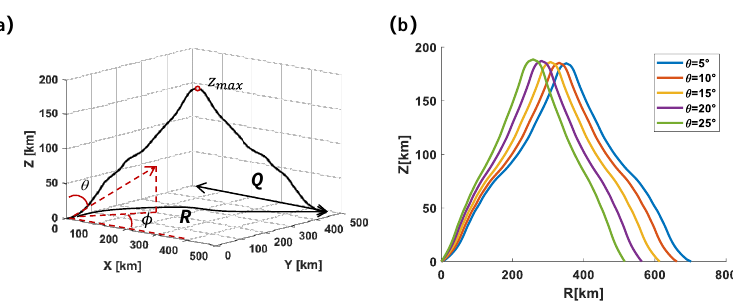
Figure 2. ( a ) Propagation trajectory of the tau-p model in a phase loop. R represents the infrasound propagation distance of a phase loop in Equation (2); φ denotes the azimuth angle in Figure 1, θ indicates the angle of elevation; z represents the altitude of infrasound propagation; z max represents the maximum altitude that a phase loop can propagate; Q represents the lateral offset of infrasound propagation in Equation (4). ( b ) Infrasound propagation trajectories at different elevation angles in a phase loop. z denotes altitude; the angle values θ are from 5 to 25 at intervals of